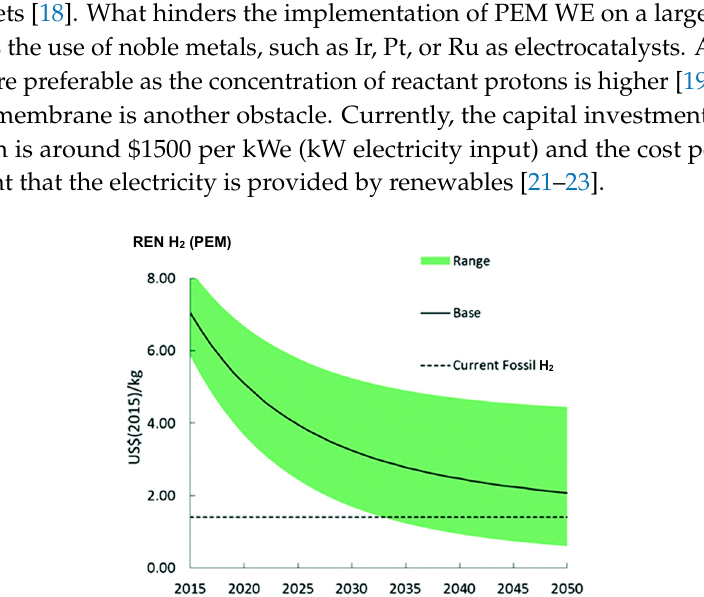
Figure 1. Learning curve for renewable PEM H 2 production showing the projected levelized costs until 2050 per kg H 2 in USD. Reprinted with permission from [24]. Copyright 2018, The Royal Society of Chemistry.